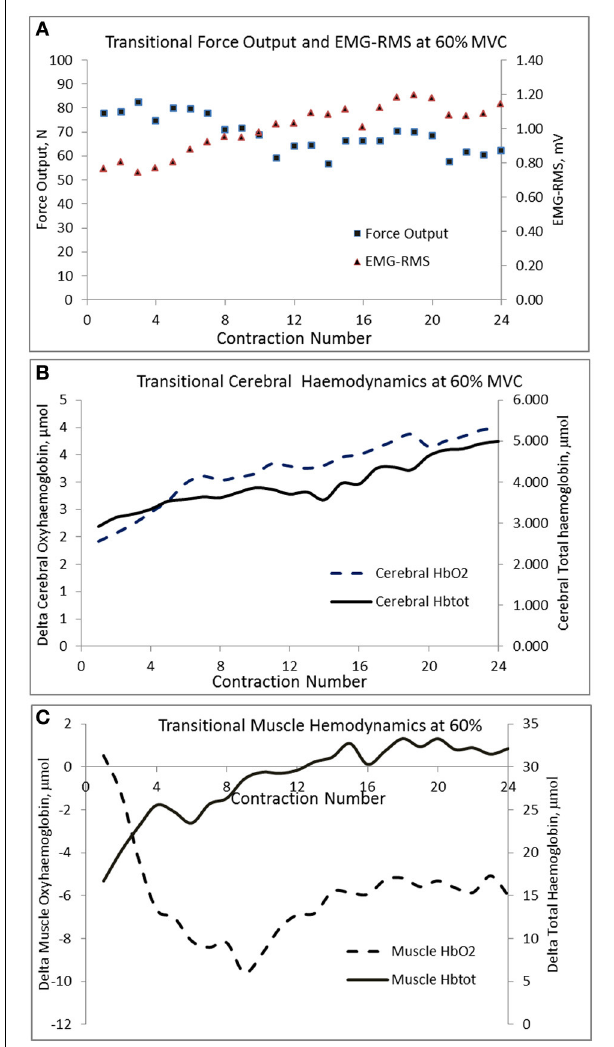
FIGURE 5 | Transitional changes in force output, cerebral, and muscle hemodynamic responses during the 24 contractions of the biceps brachii at 60% MVC in a representative